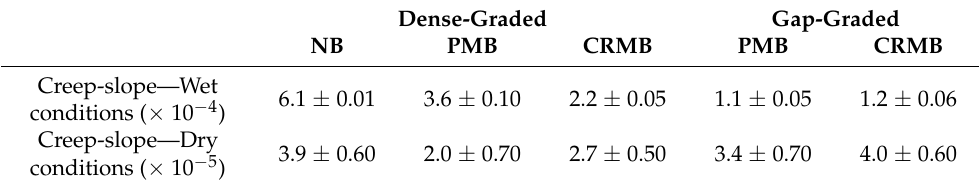
Figure 5. Hamburg Wheel-Tracking Test Results: ( a ) Wet and ( b ) Dry Conditions. Table 3. Creep Slope (CS) in Wet and Dry Conditions.